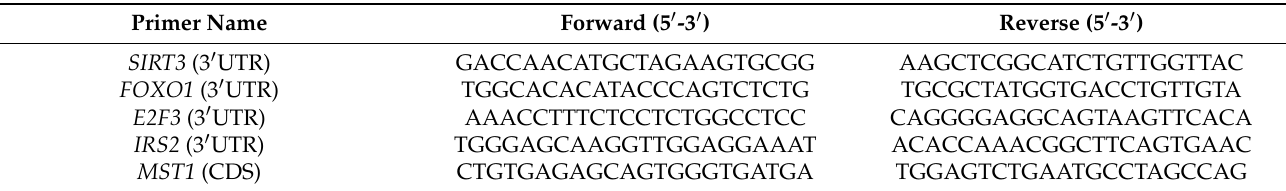
Table 2. The primer sequences of aging-related genes for